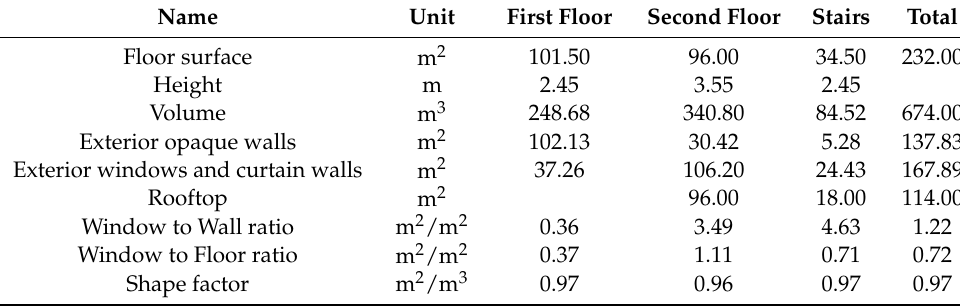
Table 3. Geometrical characteristics of the Solar House.